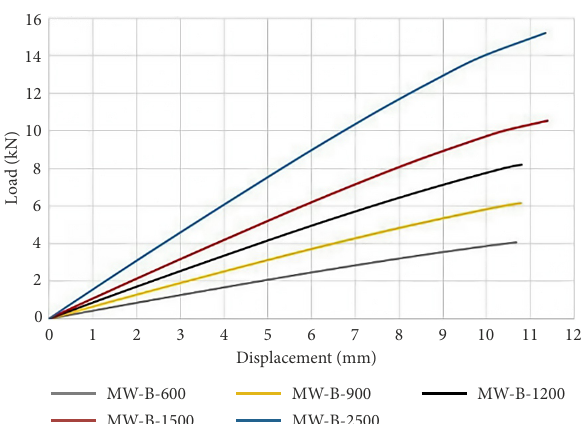
Figure 7. Load-displacement curves for MW panels with different lengths